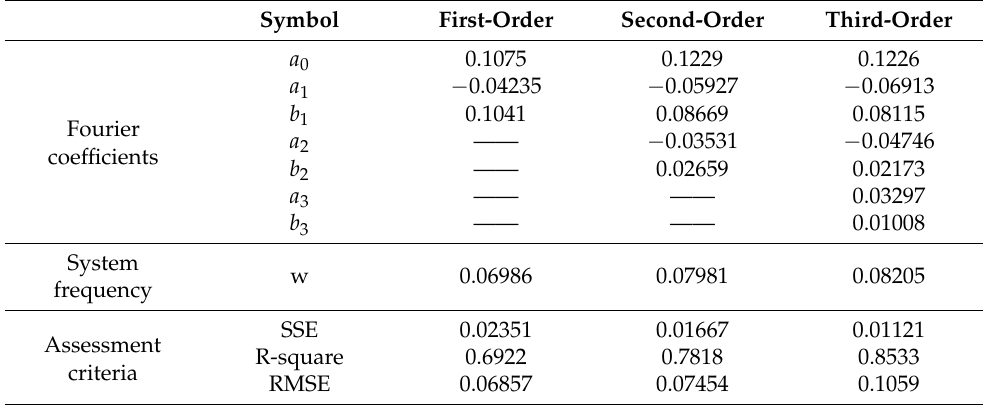
Table 6. Fourier coefficients and different types of fitting errors considering various orders of Fourier series for stress leveling of 10